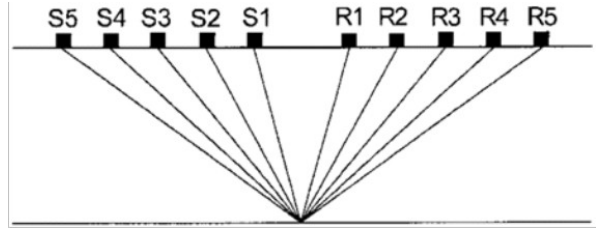
Figure 2. Common Mid Point (CMP) acquisition technique, where “S” denotes the transmitter location and “R” denotes the receiver location (Huisman,